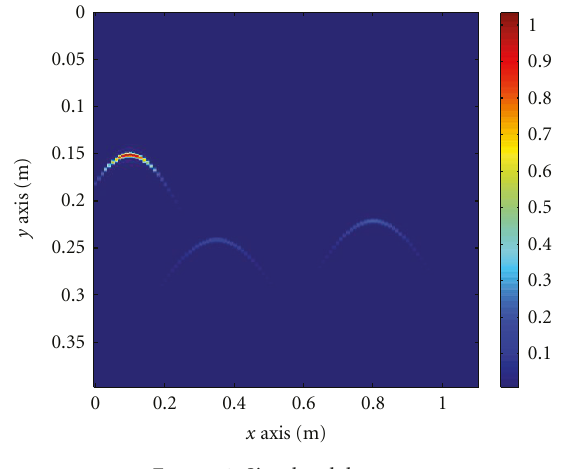
Figure 1: Simulated data